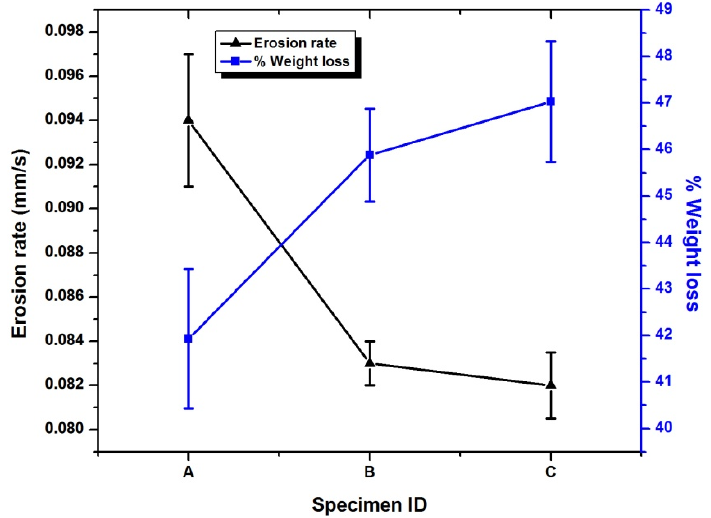
Figure 9. Percentage weight loss and erosion rate of CFRE-Cs with and without NDs. Specimen A represents CF/epoxy composite, specimen B represents CF/epoxy/0.2 wt% NDs composite, and specimen C represents CF/epoxy/0.4 wt% NDs composite.